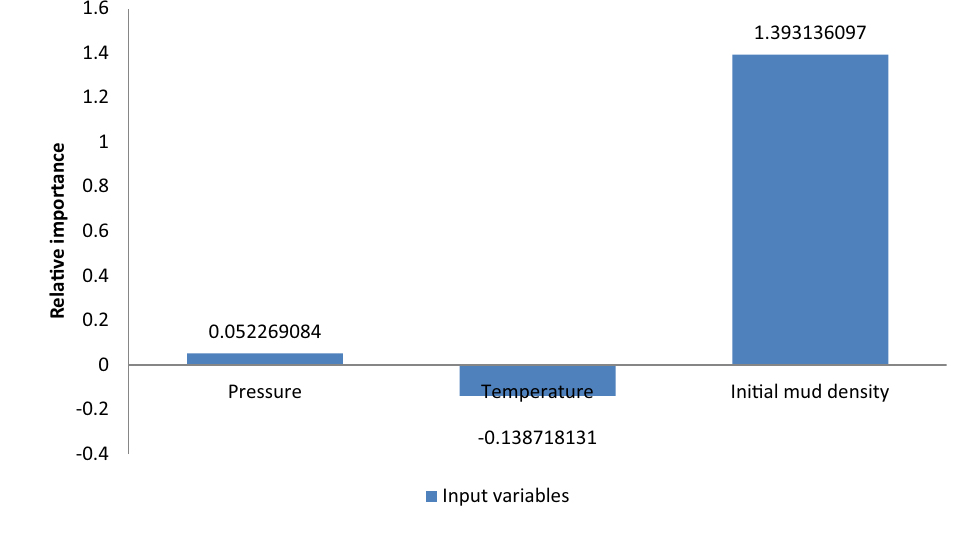
Fig. 4 Relative importance of